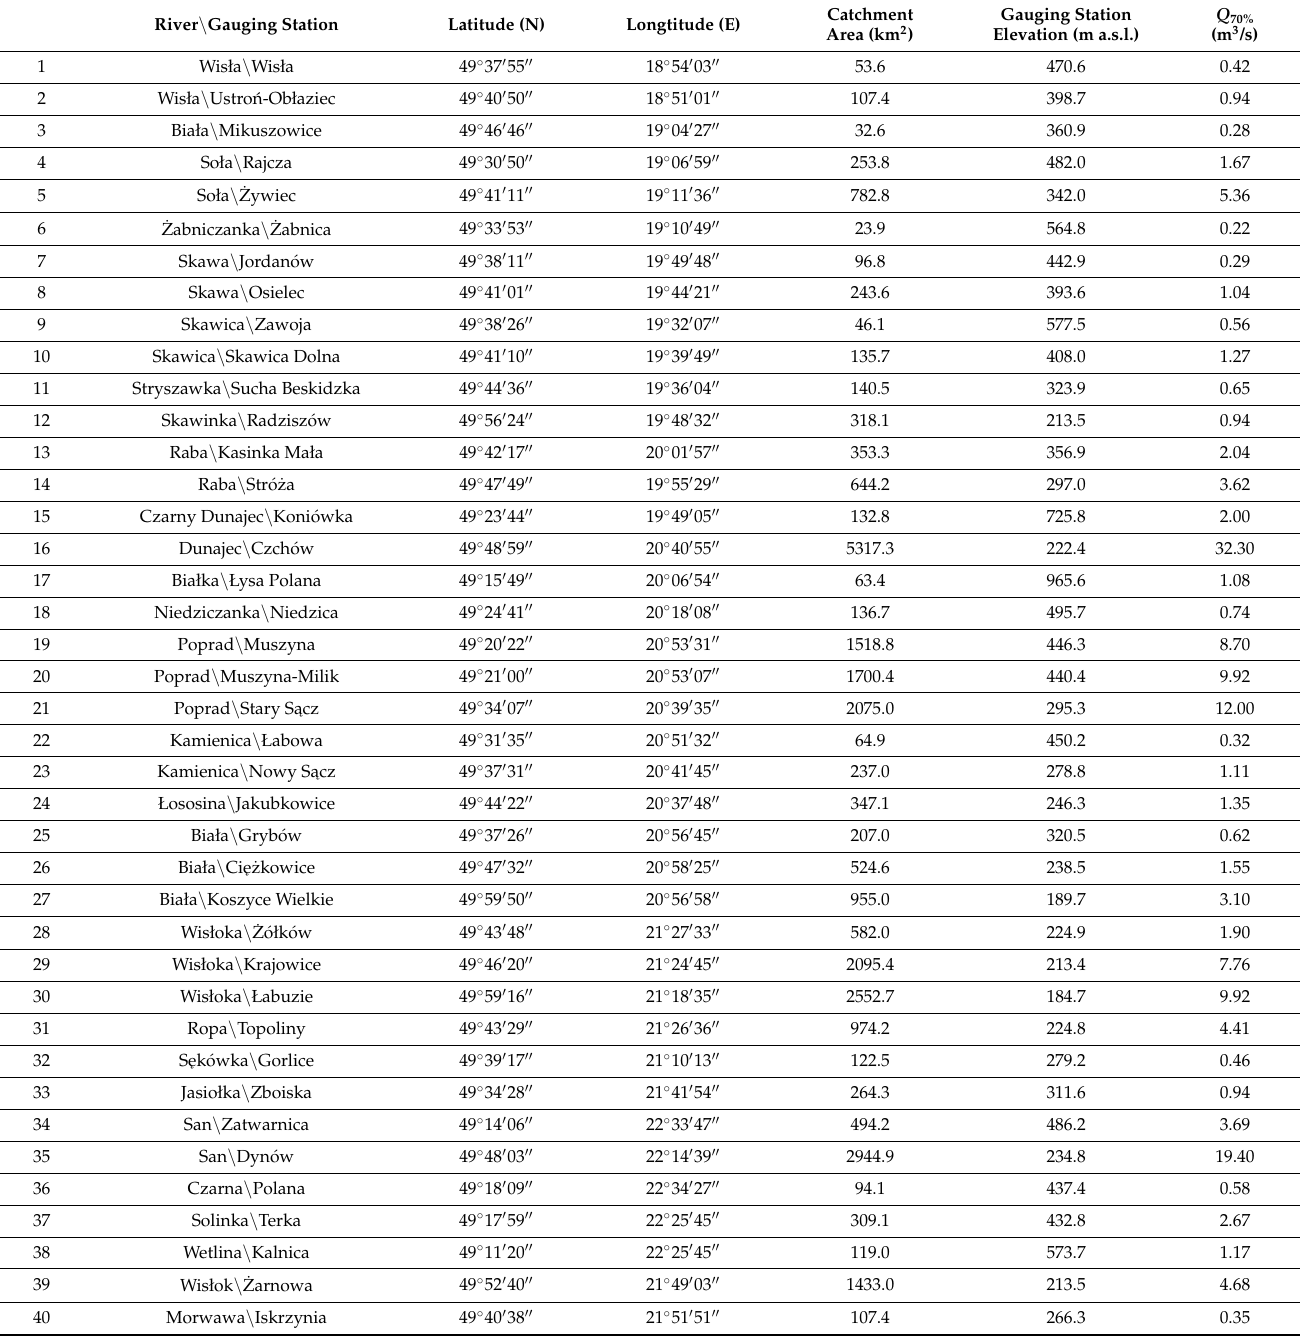
Table 1. Characteristic of gauging cross-sections and catchments enclosed by those sections